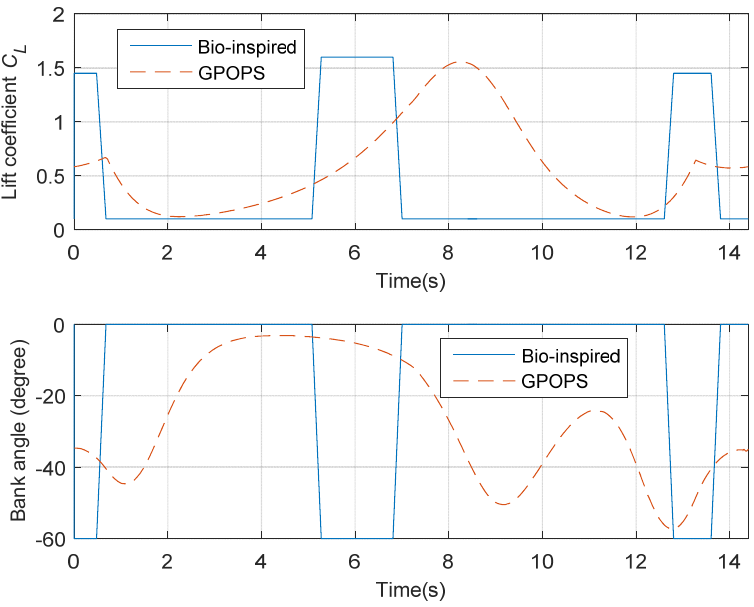
Figure 17. Time histories of the control inputs for the GPOPS and proposed bio ‐ inspired methods.